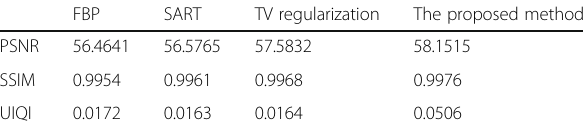
Table 1 Comparison of image evaluation parameters of different reconstruction algorithms (SNR = 20 dB) FBP